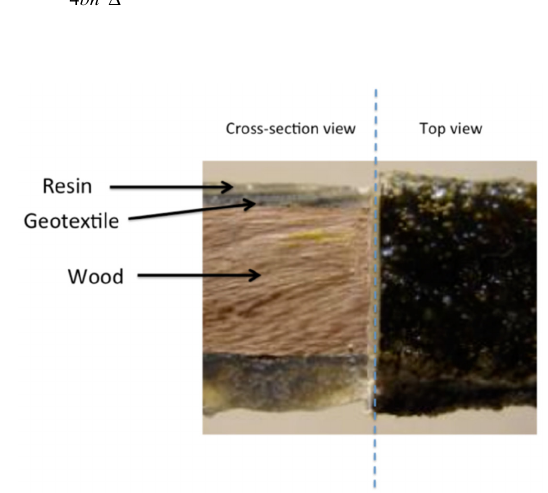
Figure 1. Cross-section view with sequence of layers on samples coated with geotextile fibers and polyurethane composite resin.